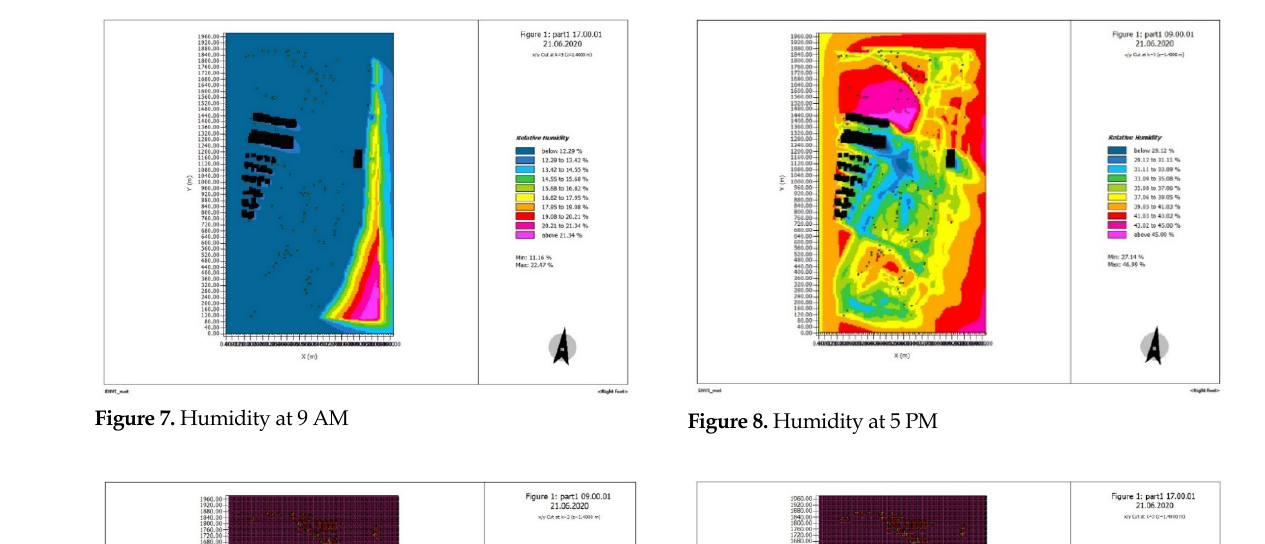
Figure 5. Temperature graph of 9 AM Figure 6. Temperature graph of 5 PM